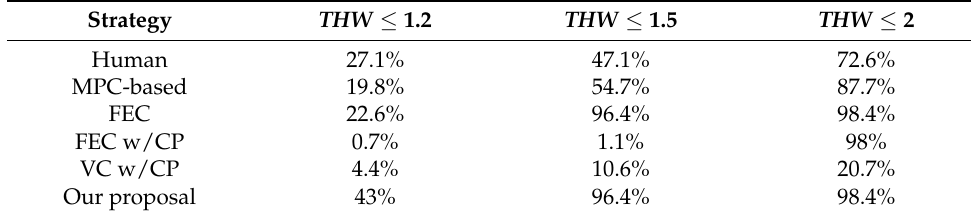
Table 5. Ratio of comfort for different strategies.